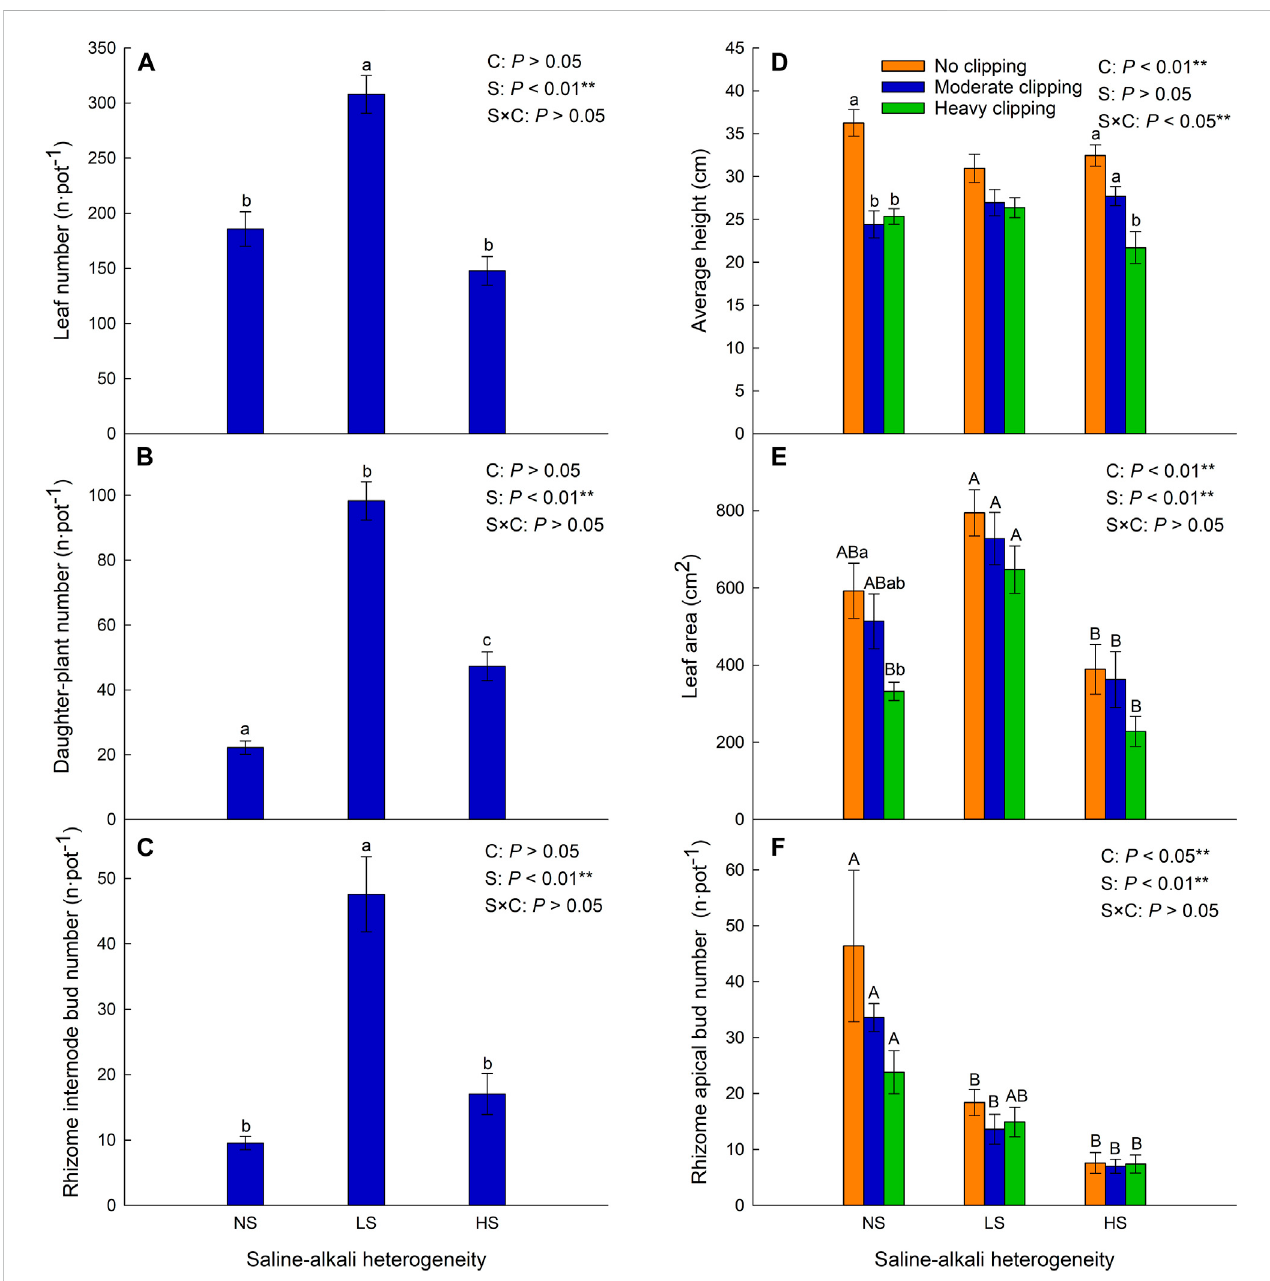
FIGURE 3 Effects of saline-alkali heterogeneity (S), clipping (C) and their interaction (S×C) on the leaf number (A) , daughter plant number (B) , rhizome internode budnumber (C) ,averageheight (D) ,leafarea (E) ,andrhizomeapicalbudnumber (F) of L.chinensis .Differentlowercaselettersrepresentsigni fi cantdifference ( p < .05) of the clipping treatments in the same saline-alkali stress, and different uppercase letters represent signi fi cant difference ( p < .05) of the saline-alkali heterogeneity in the same clipping